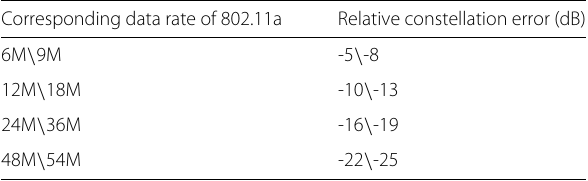
Table 4 Equalization error leads to a fractional increase in RCE Corresponding data rate of